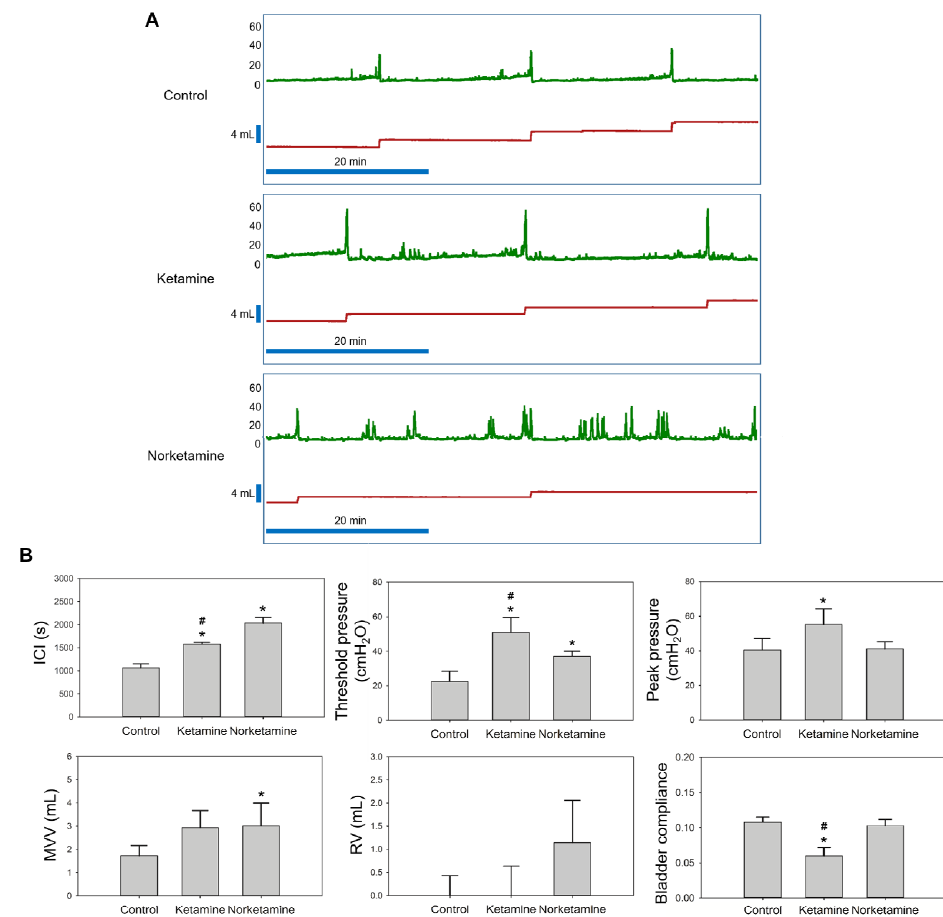
Figure 2. The cystometric analysis (CMG) of control, ketamine-treated, and norketamine-treated rats. ( A ) A one-hour period of CMG in each group observed with the recording software, Biopac Student Lab 4.1 (Biopac Systems Inc., Santa Barbara, CA, USA); ( B ) Statistical analysis of the intercontraction intervals (ICI), threshold pressure, peak pressure, residual urine volume (RV), mean voiding volume (MVV), and bladder compliance. * indicates statistical differences in comparison with the control group, p < 0.05; # indicates statistical differences in comparison with the norketamine group, p <